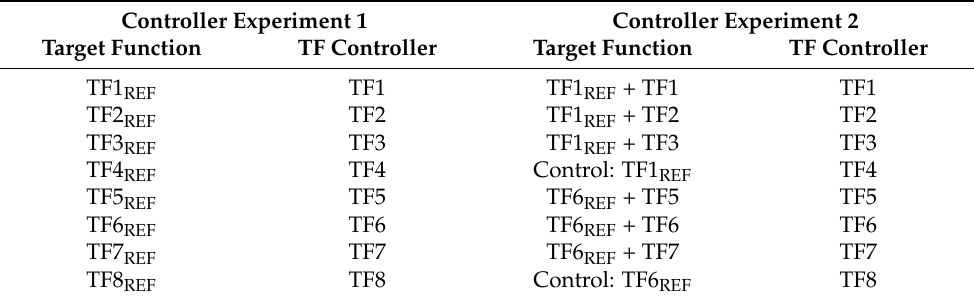
Table 3. Scheme to indicate which reference data were used in the target function for the two controller